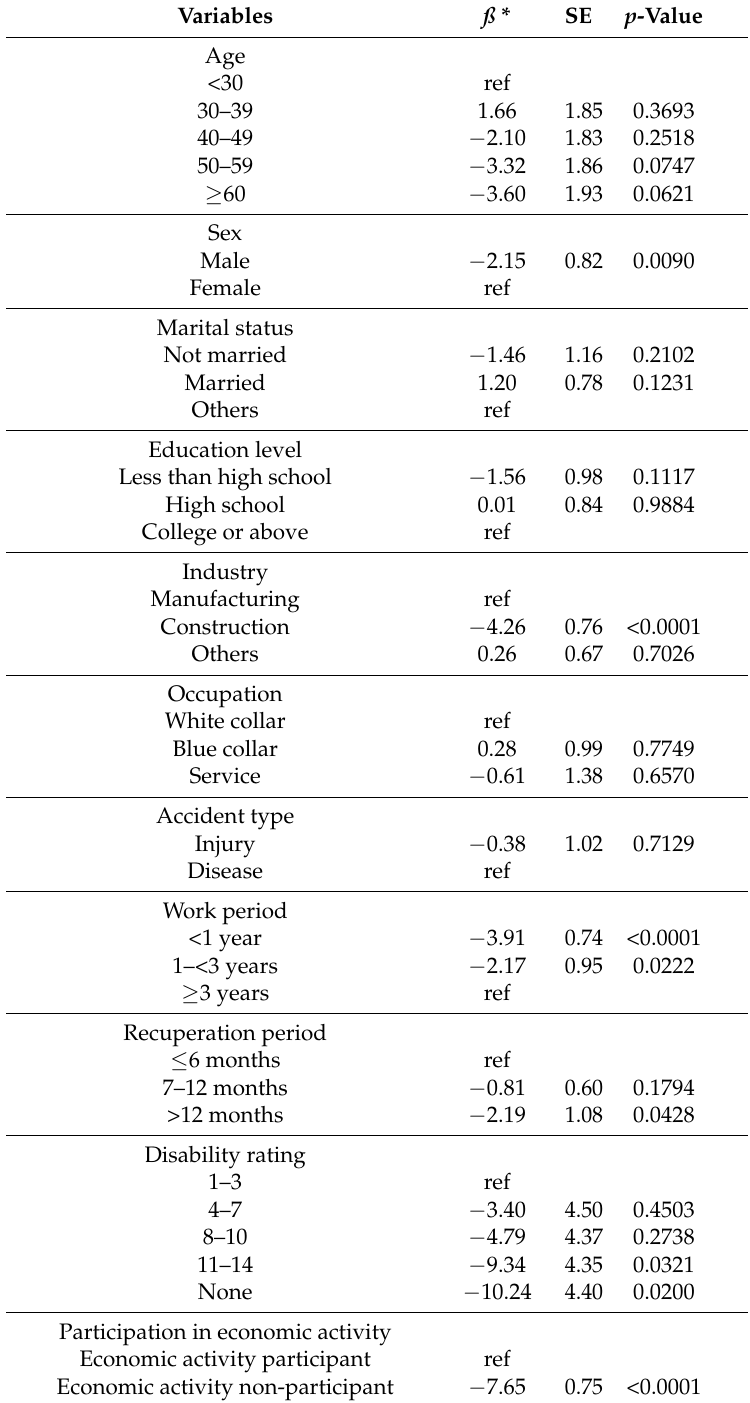
Table 5. Relationship between the general characteristics and four-year average of post-accident income minus the income before the industrial accident (unit: million